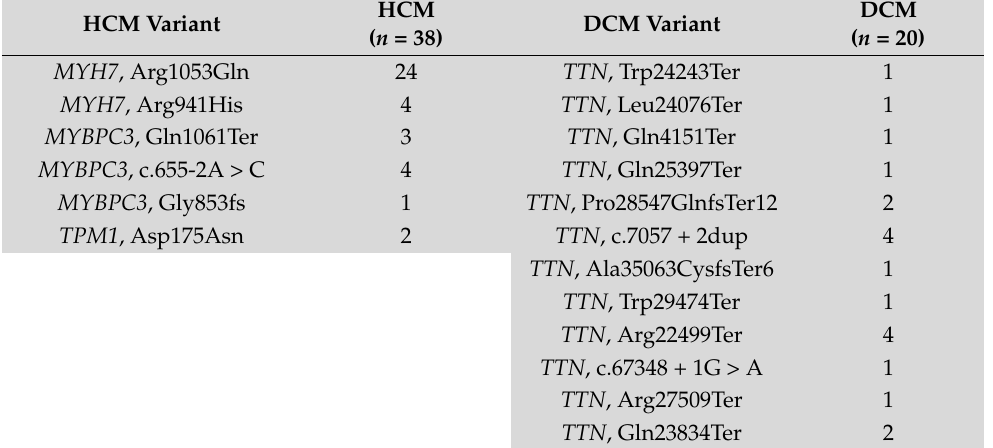
Table 2. Pathogenic or likely pathogenic genetic variants for HCM and DCM in the METSIM